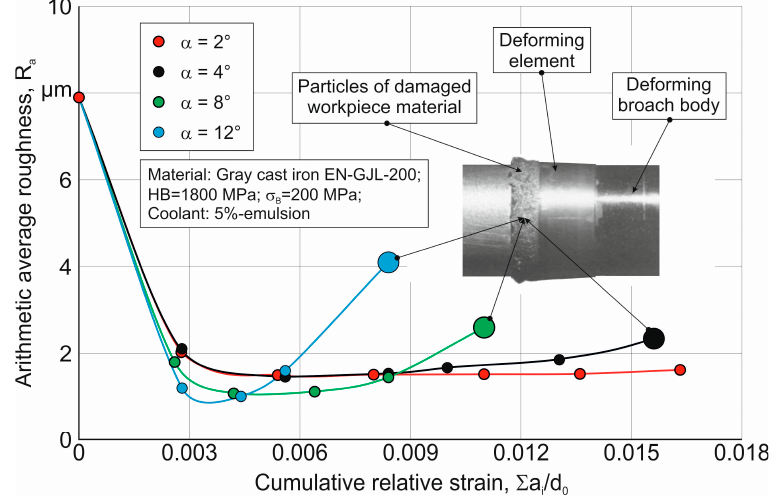
Figure 7. Effect of cumulative relative strain on the arithmetic average roughness R a